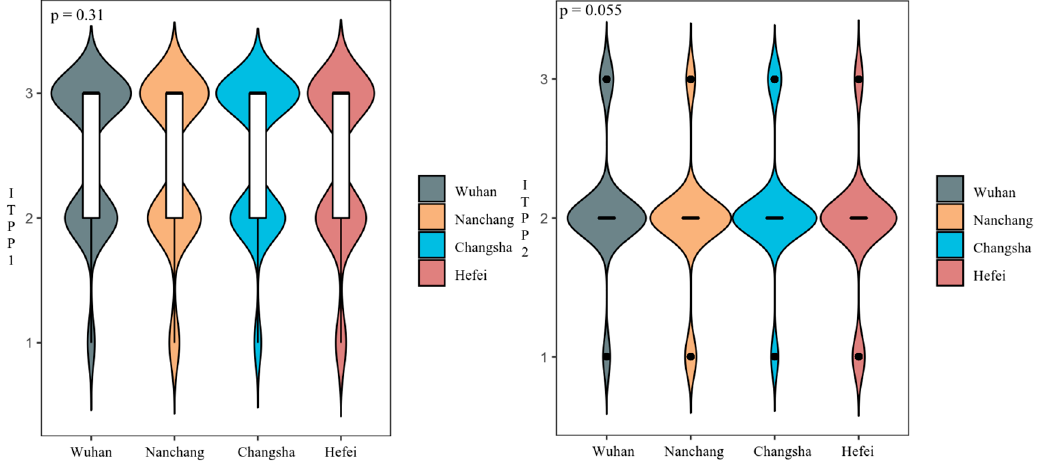
Figure 5. Results of homogeneity of variance test (95% CI).